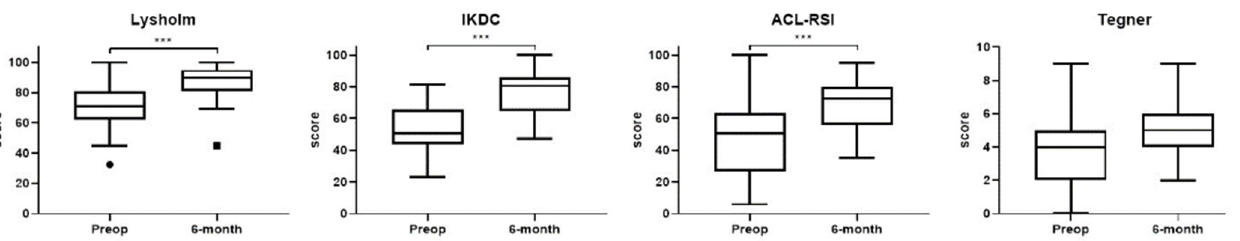
Figure 5. Box-plots showing differences in outcome scores from pre-operative to 6-month follow-up after surgery. The black line inside the box represents median value. The lowest bar represents the minimum value, the bottom and top of the boxes represent the interquartile range (25th and 75th percentiles), and the top bar represents the maximum value. Points outside the limits represent outliers *** p < 0.001.